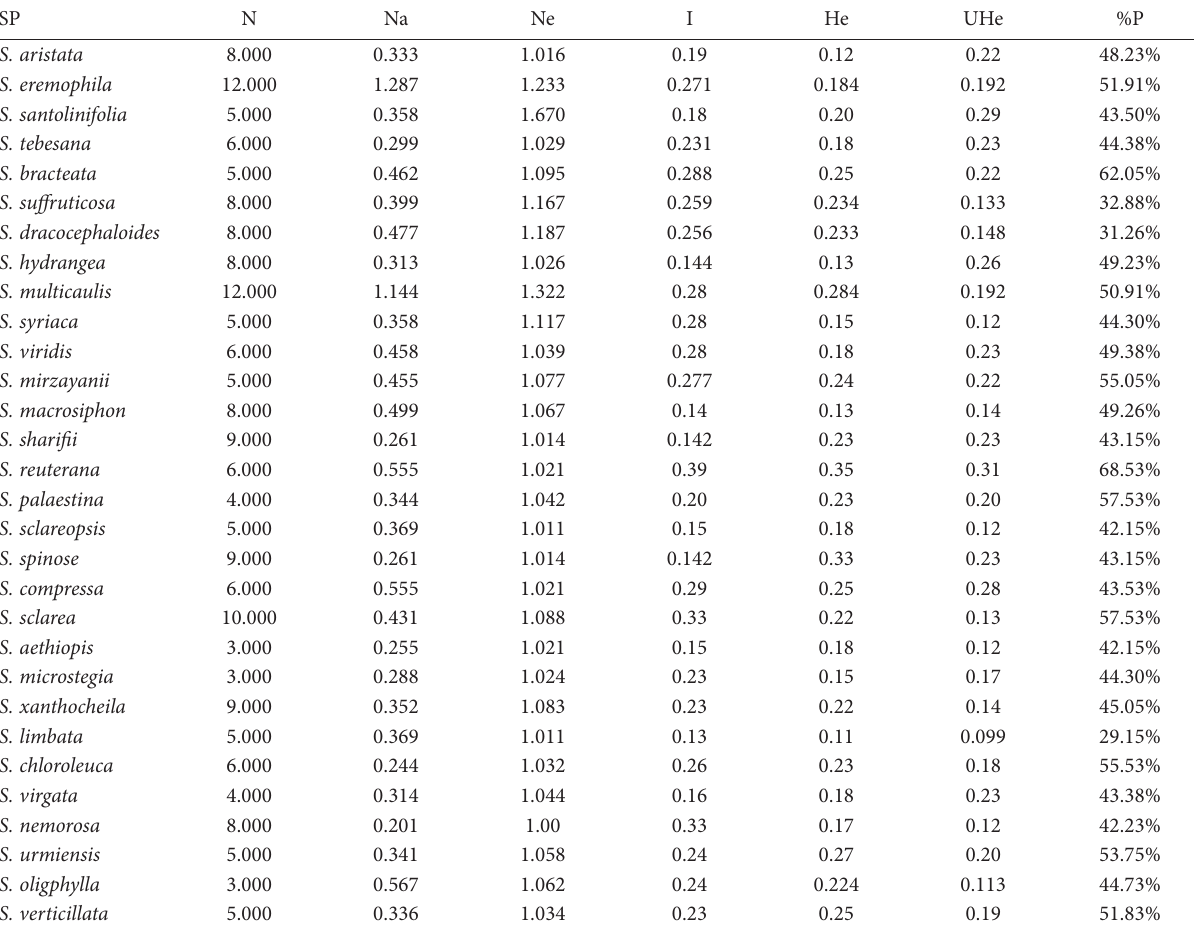
Table 3. Genetic diversity parameters in the studied Salvia species. SP N Na